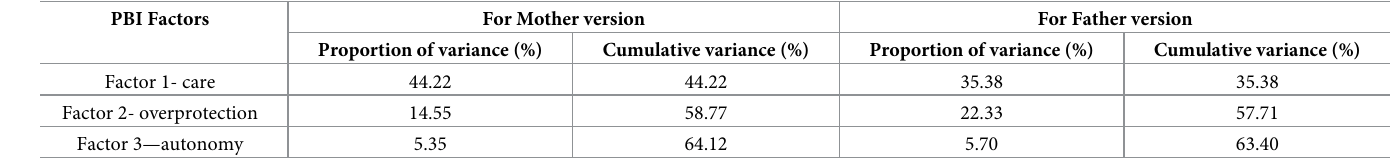
Table 4 shows the percentages of the explained variance for PBI in the youth group. The three factories explain 60.00% of the cumulative variance in the PBI version of the mother and 61.62% of the cumulative variance in the PBI version of the father. Results of test-retest corrrelation in group of adults The above Table 5 shows the weakest stability obtained in the Factor 1 range, while Factors 2 and 3 show high stability over time. Table 2. Total explained variance for identified factors of Polish version of PBI (in group of adults, n =